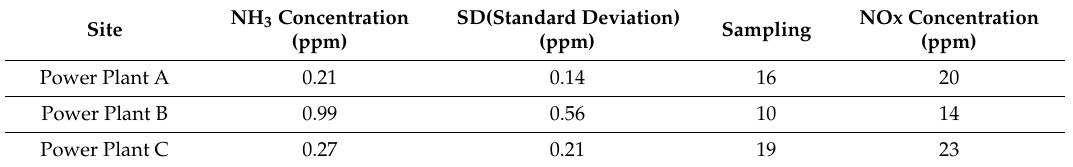
Table 2. NH 3 concentration of the investigated bituminous coal power plants.